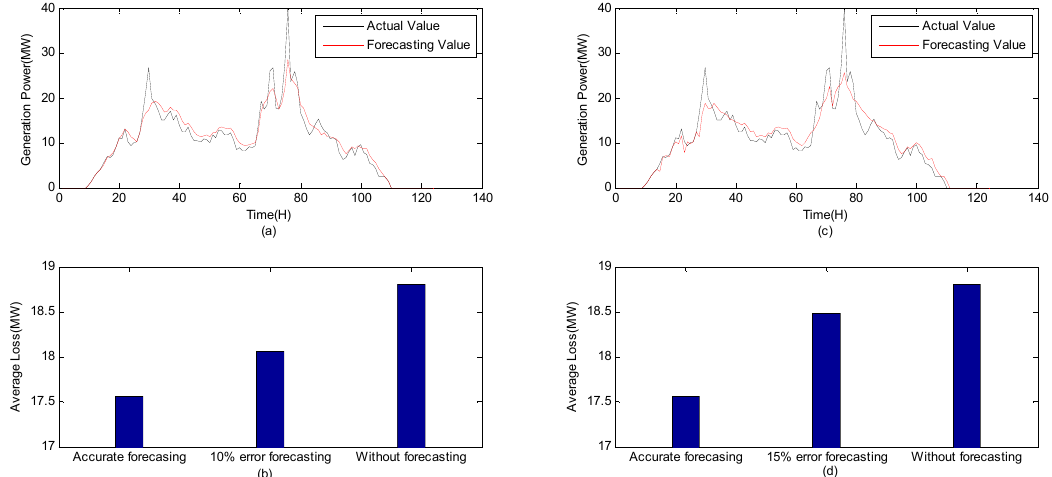
Figure 9. Forecasting results under a 10-min action delay. ( a , c ) show the different iteration time forecasting results, where the iteration time is 150 s in ( a ), and 120 s in ( c ). ( b , d ) show the average power losses under different settings.